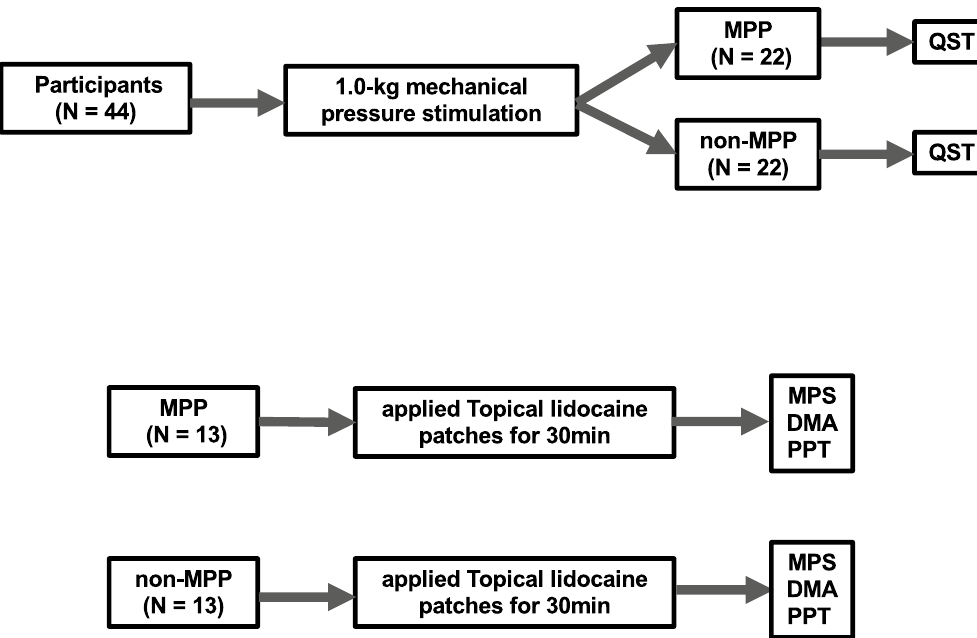
Figure 1. Flowchart of the main experiment procedure and the additional experiment